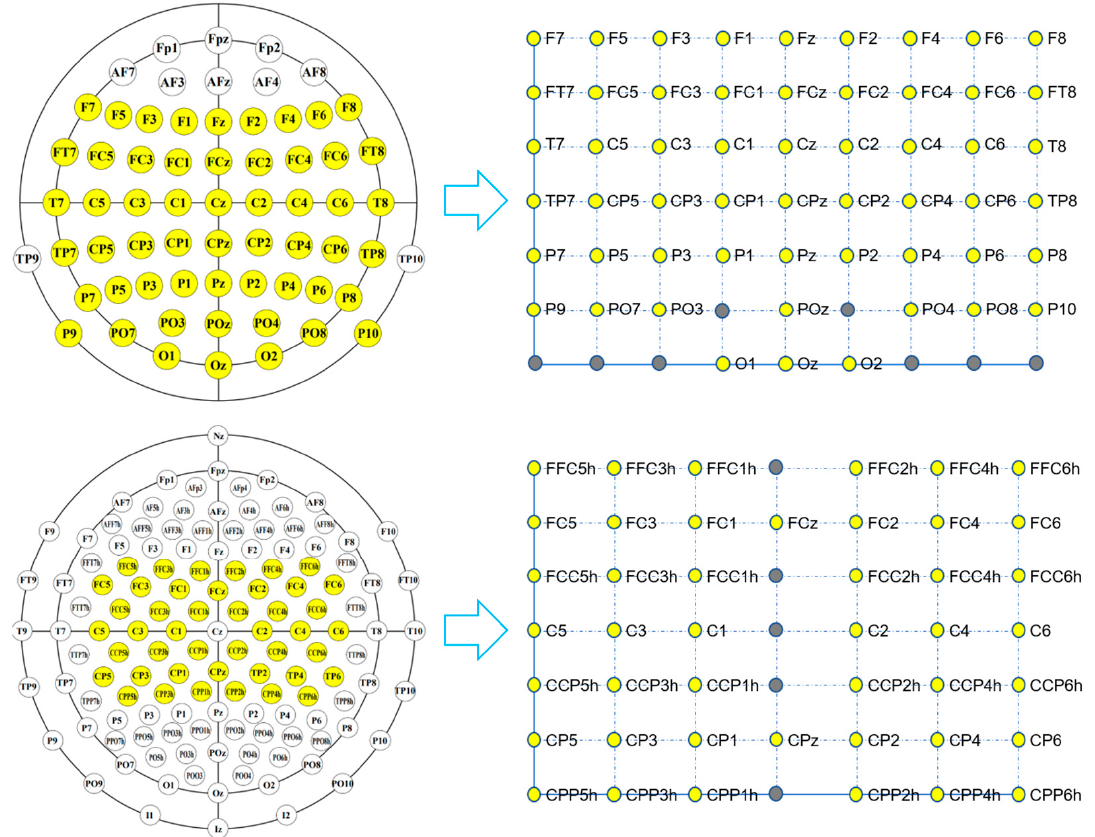
Figure 2. Correspondence between the electrode locations and matrix coordinates. The upper and lower panels show the correspondence between the electrode locations and matrix coordinates for the EBDSDD and HGD, respectively. The values of the yellow points in the matrix are the potential values of the corresponding electrodes, and values of the gray points are set to 0. For the EBDSDD, a total of 55 electrodes are used, and the size of the corresponding matrix is 7 × 9. For the HGD, a total of 44 electrodes covering the motor cortex (all central electrodes except Cz, which is used as the recording reference electrode) are used, and the size of the corresponding matrix is 7 × 7.